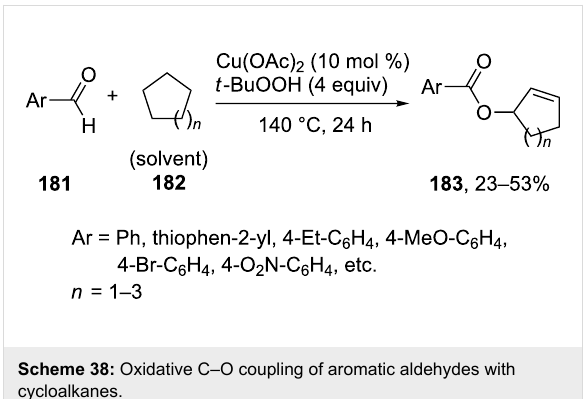
R 5 = H, Me, t- Bu, OMe, NEt 2 , Cl, Br, etc